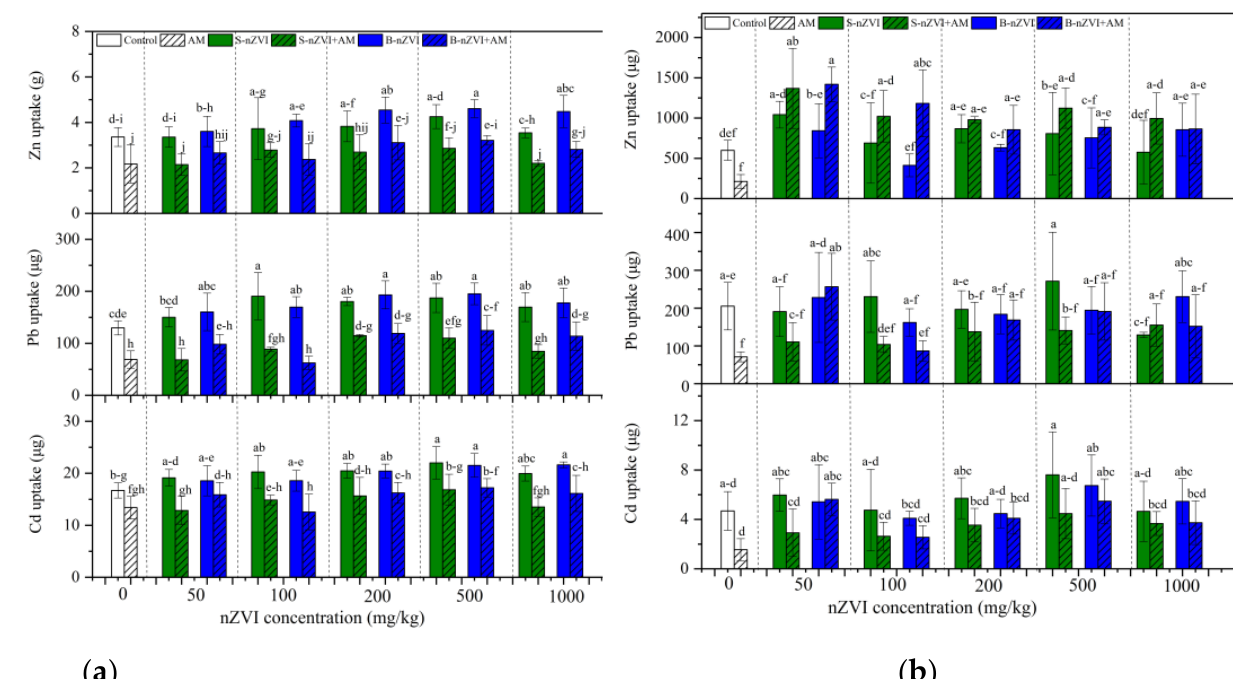
Figure 5. Uptake of Cd, Pb and Zn in plant shoots ( a ) and roots ( b ). Control represents the treatment without AM inoculation or nZVI; AM represents the treatments inoculated with A. mellea ZZ; S-nZVI represents the treatments that received S-nZVI; S-nZVI+AM represents the treatments that received S-nZVI and AM inoculation; B-nZVI the treatments that received B-nZVI; B-nZVI+AM represents the treatments that received B-nZVI and AM inoculation. Different letters above the bars indicate significant differences ( p < 0.05). Three-way and two-way ANOVA results are shown in Tables 2 and 3, respectively.